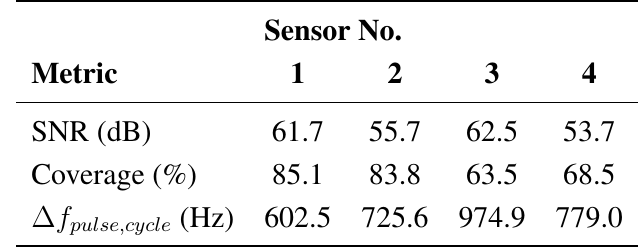
Table 5. Performance metrics of the different sensor positions during breath holding in a standing posture. Values are averaged for all subjects (the total signal length is 160 s). ∆ f is the average peak-to-peak frequency change of a cardiac cycle. pulse,cycle